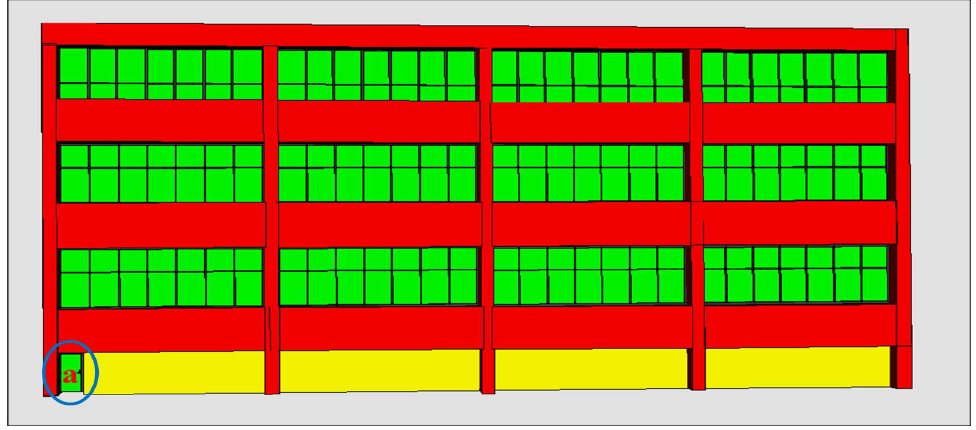
(c) Automatic reconstruction of a multi-floor building model with Rule Set 4 . Compared with the reference model, the error is marked out in blue circle. Figure 5: Comparison of manual processed model and grammar-based automatic reconstructed models with different rule sets for a multi-floor building. Colours in the reconstructed models stand for window in green, wall patch in yellow, and base wall in red. In: Proceedings of the XIXth ISPRS Congress, IAPRS